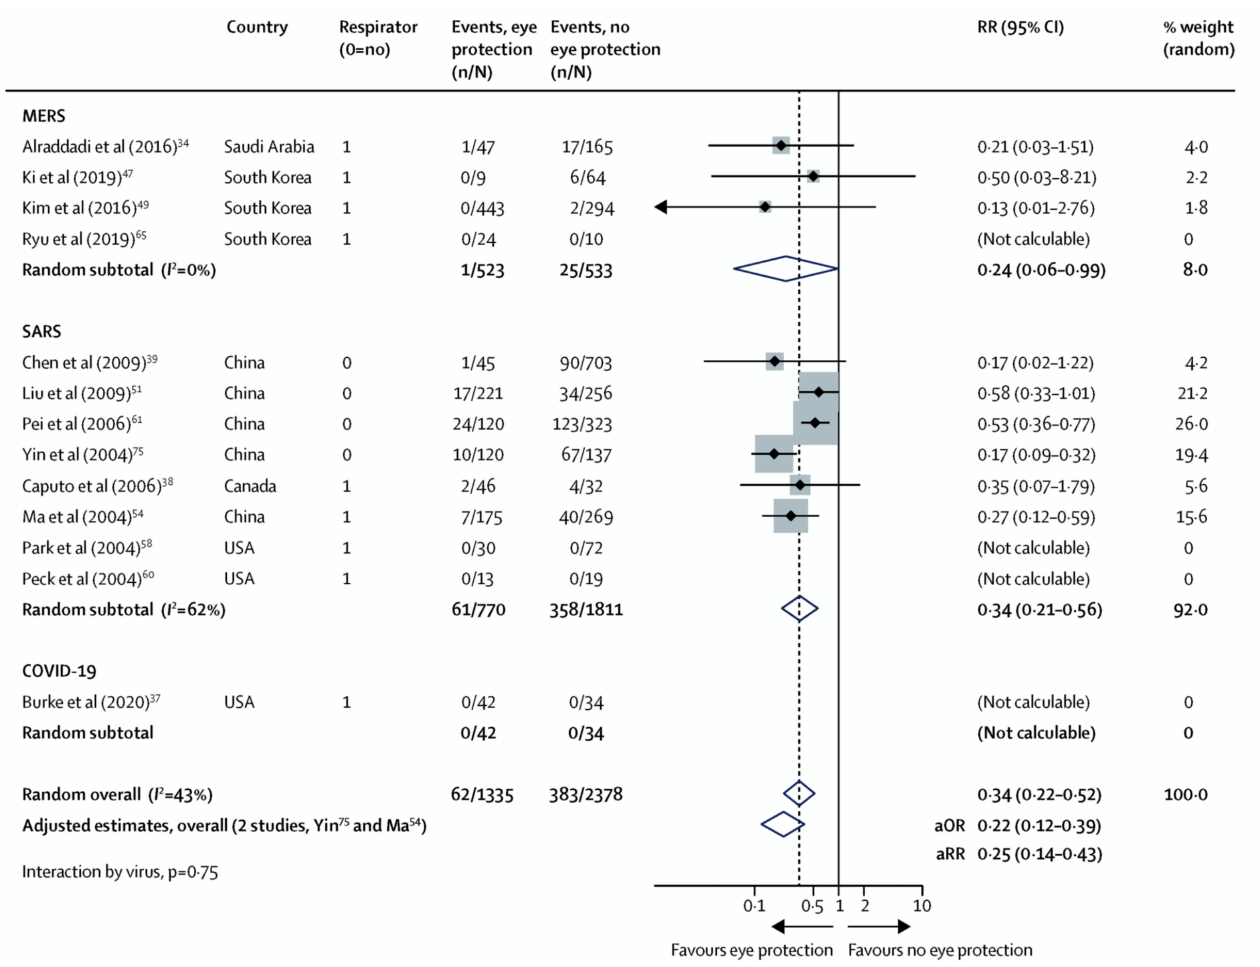
Figure 5. Forest plot showing the association of eye protection with risk of MERS, SARS-CoV-1 (SARS) and SARS-CoV-2 (COVID-19). The plot diagram represents unadjusted estimates. MERS = Middle East respiratory syndrome. SARS = severe acute respiratory syndrome. RR = relative risk. aOR = adjusted odds ratio. aRR = adjusted relative risk